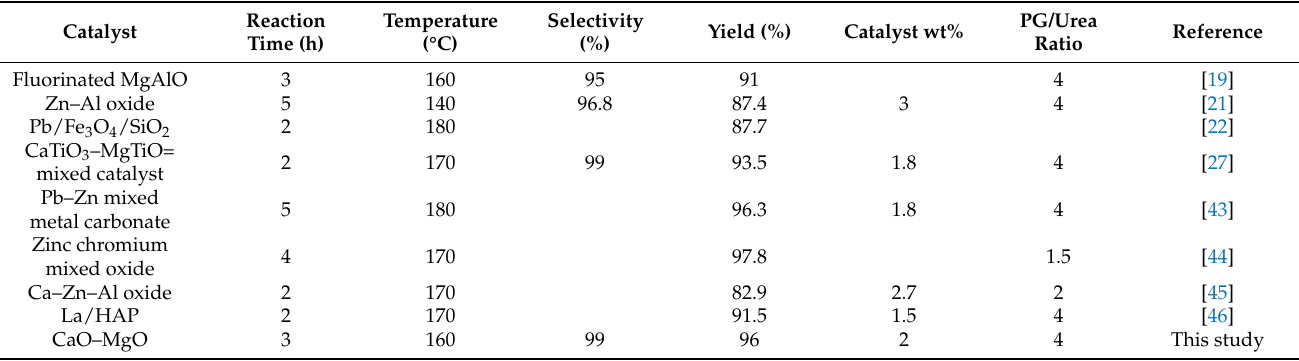
Table 2. Comparative analysis for PC